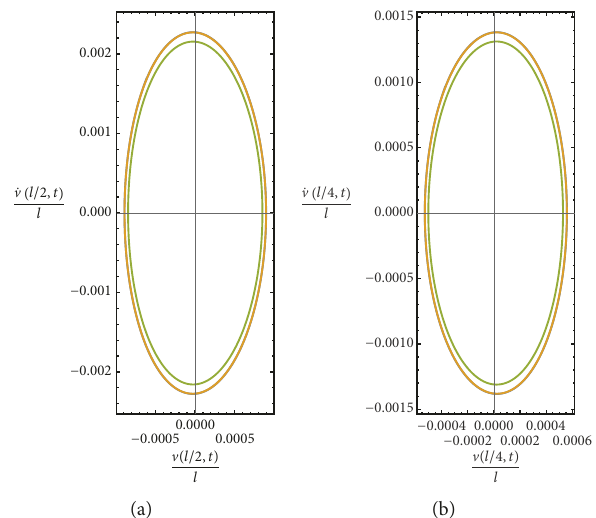
Figure 5: Case-study 1: reconstituted phase plot ( V , ̇ V ) for 𝑈 2 /𝑈 𝑐 = 0.11 at (a) half-span and (b) quarter-span (green line: multiple scale method; blue line: Galerkin method; orange line: finite difference